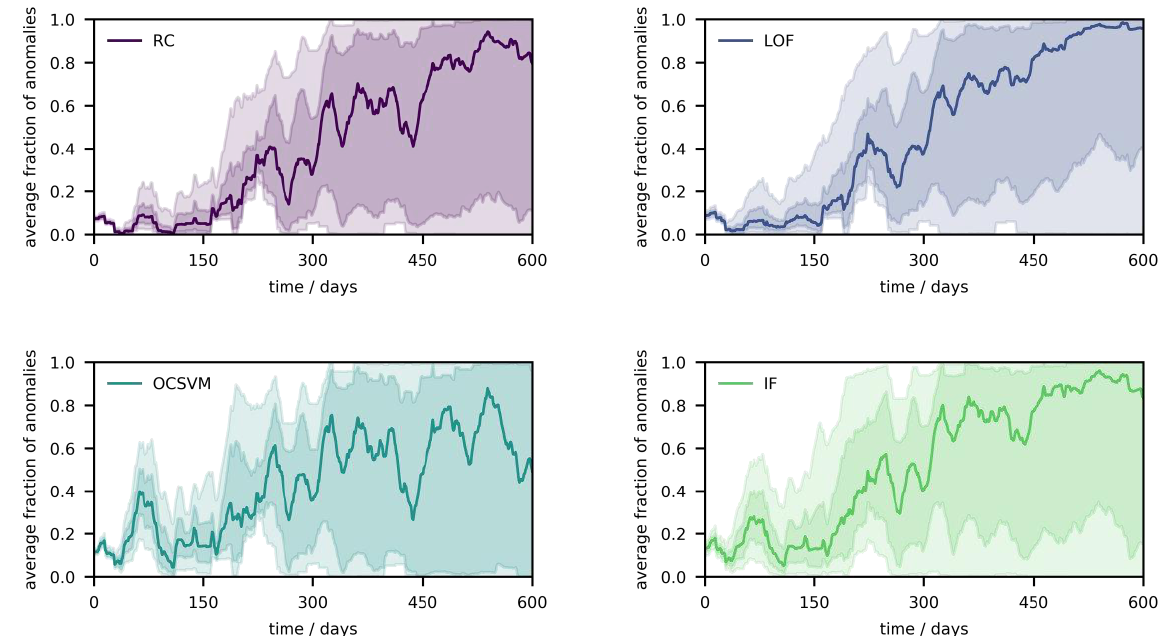
Figure 7. Performance of the four ML algorithms ( ν = 0.10) as distribution of anomalies (monthly moving average) from the population of low-cost sensor systems (q 0.50 , q 0.25–0.75 , q 0.05–0.95 ), computed in Monte Carlo simulations including laboratory calibration followed by aging.